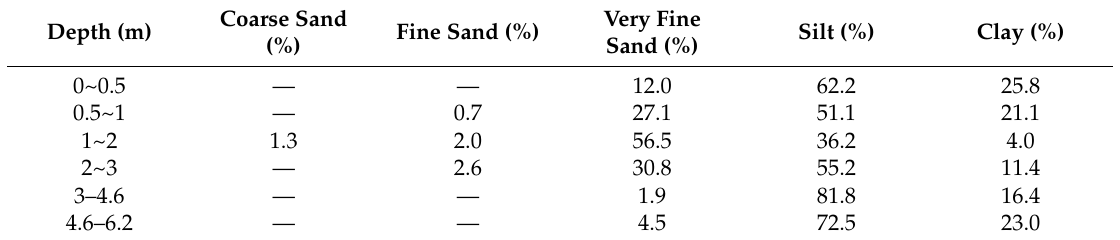
Table 2. Soil physical properties of the experimental